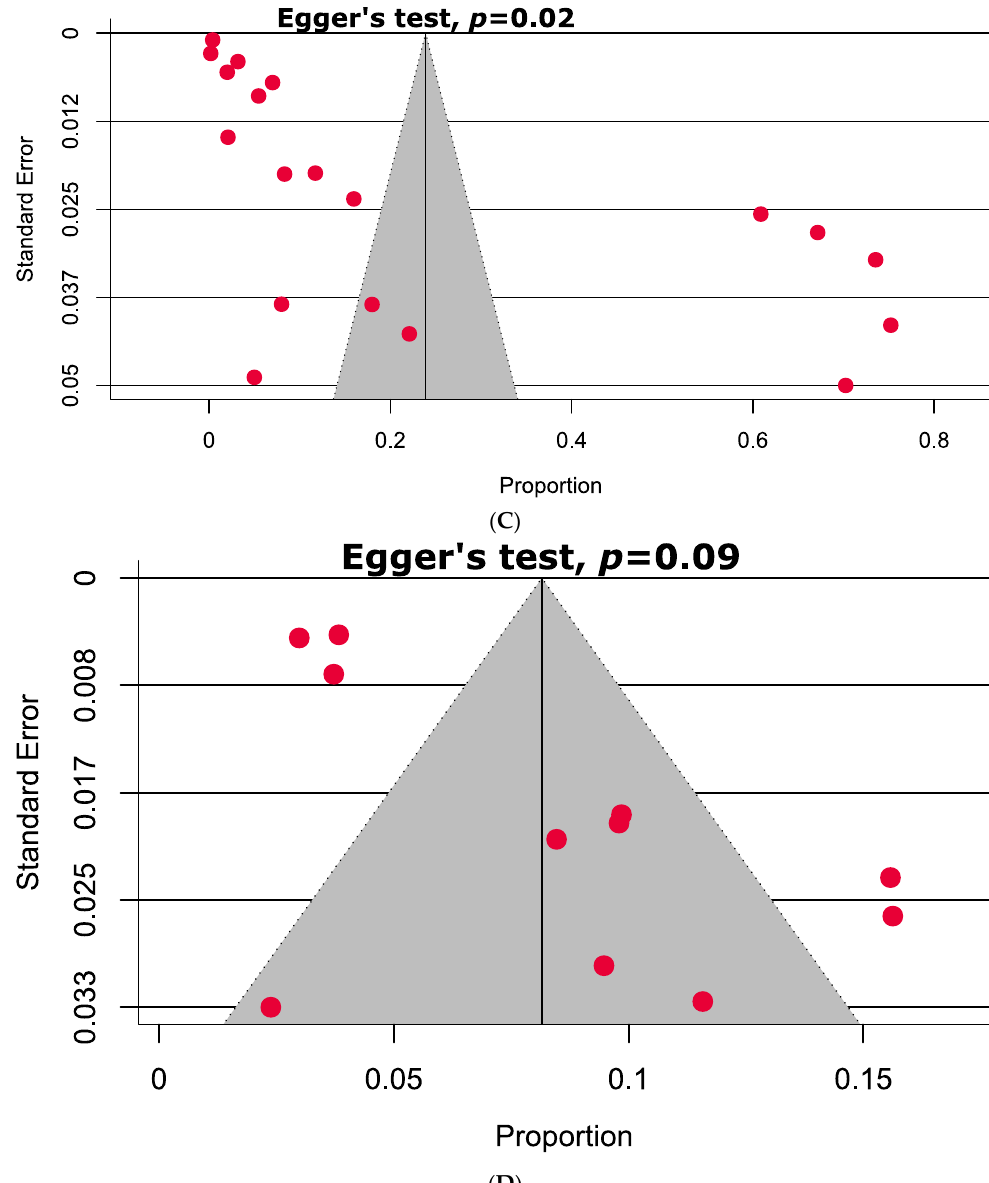
Figure 2. Funnel plots analyzing publication bias among studies evaluated ( A ) any-DR, ( B ) mono-DR, ( C ) multi-DR, and ( D ) poly-DR.